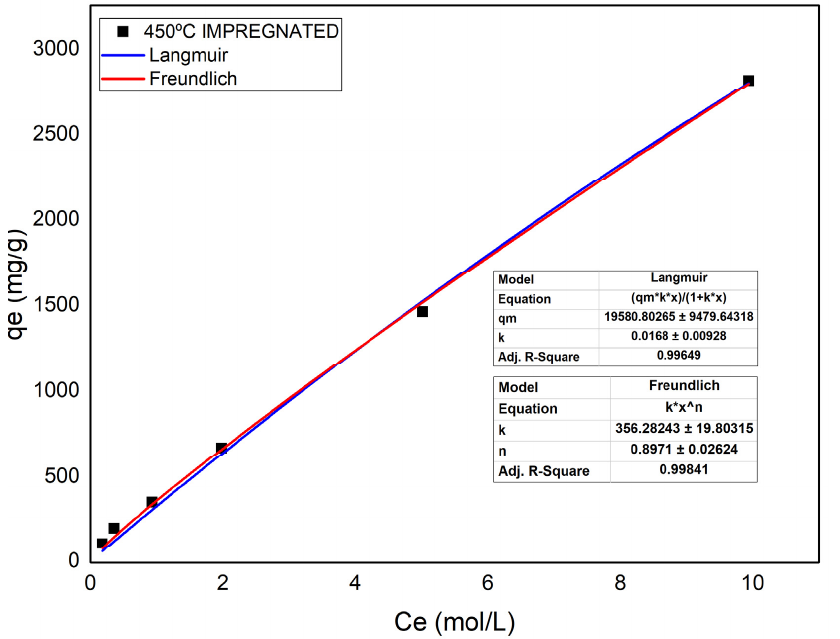
Figure 17. Langmuir and Freundlich isotherm model for adsorption experiment of chemically activated biochar obtained at 450 ◦